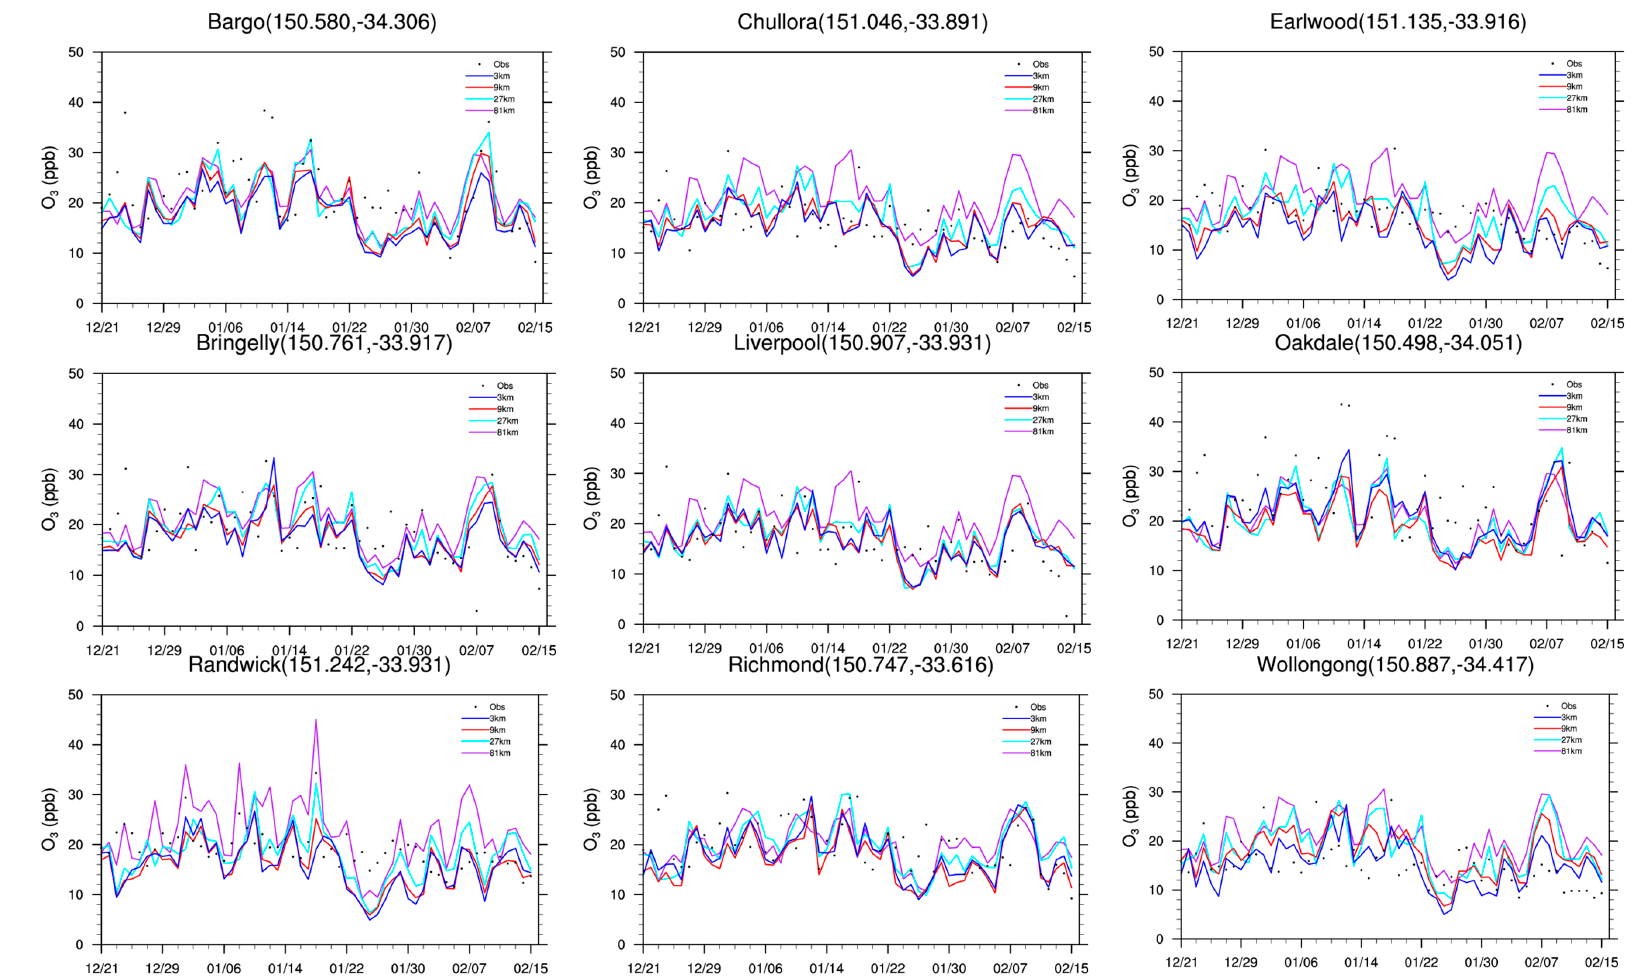
Figure 6. Observed and simulated temporal profiles of O 3 concentrations at selected sites during MUMBA. All simulation results are based on WRF/Chem-ROMS.